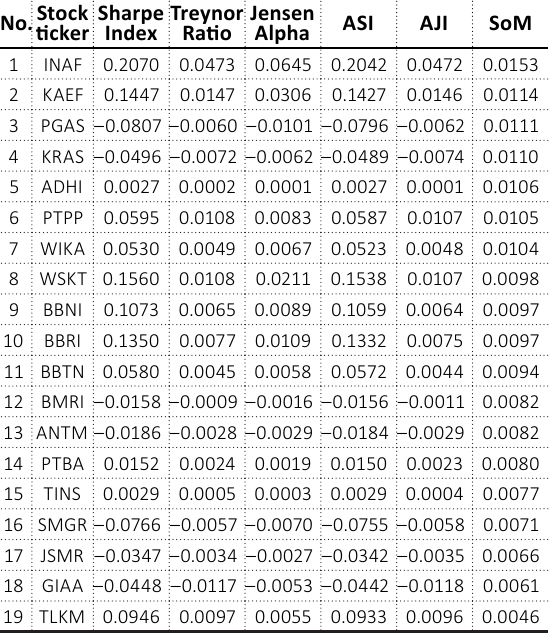
Table 3. The result of SOEs’ stock performance Source: Real-time information,